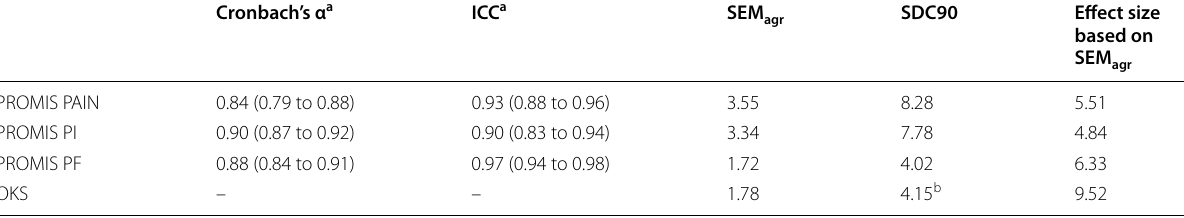
Table 3 Reliability, agreement and smallest detectable change